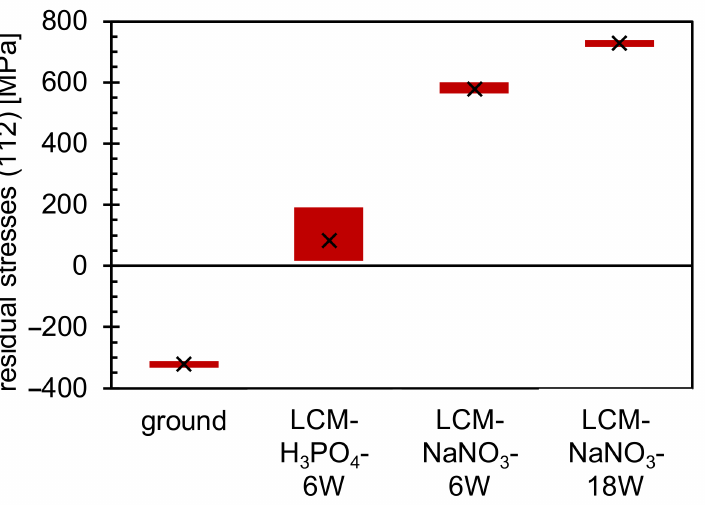
Figure 6. Residual stress measurements of ground and LCM 42CrMo4